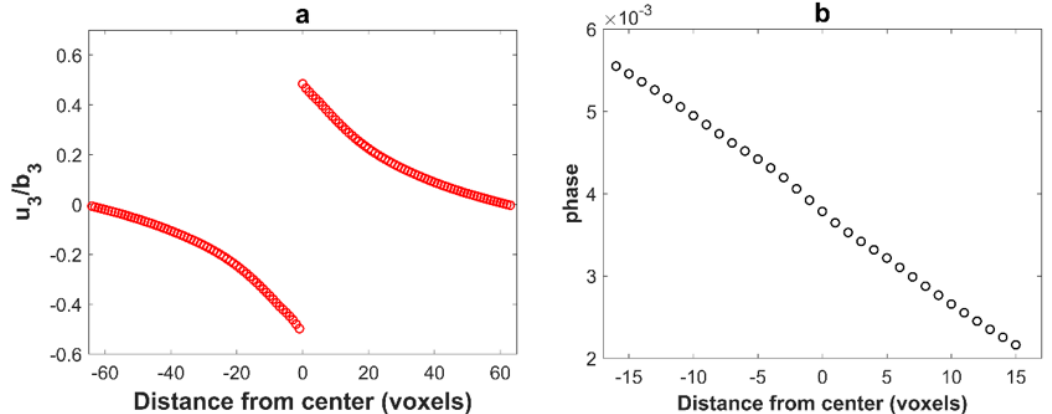
Figure 5. ( a ) Plot of the displacement field 𝑢 3 (normalized by 𝑏 3 ) along the z direction for dislocation loop illustrated on Figure 2. The voxelization artifacts are removed by the sub-voxel method described above. ( b ) The phase (i.e., the displacement modulo a Burgers vector). With this correction, the